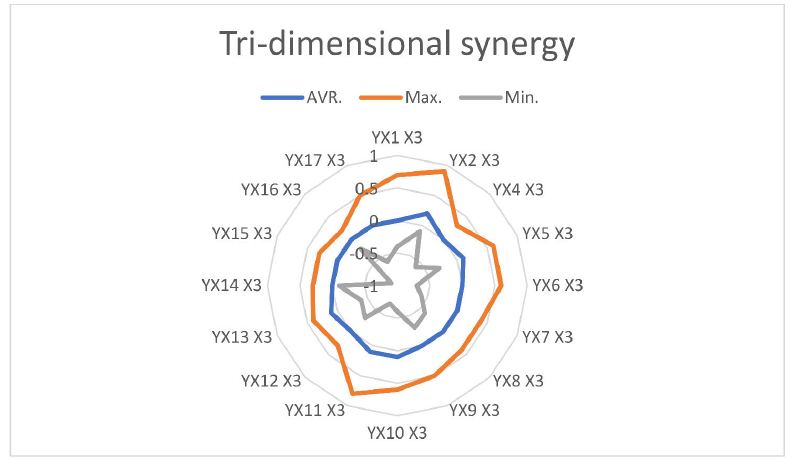
Figure 7. Tri-dimensional synergies in rapport with R&D personnel in electric industry (X 3 ). Source: Authors’